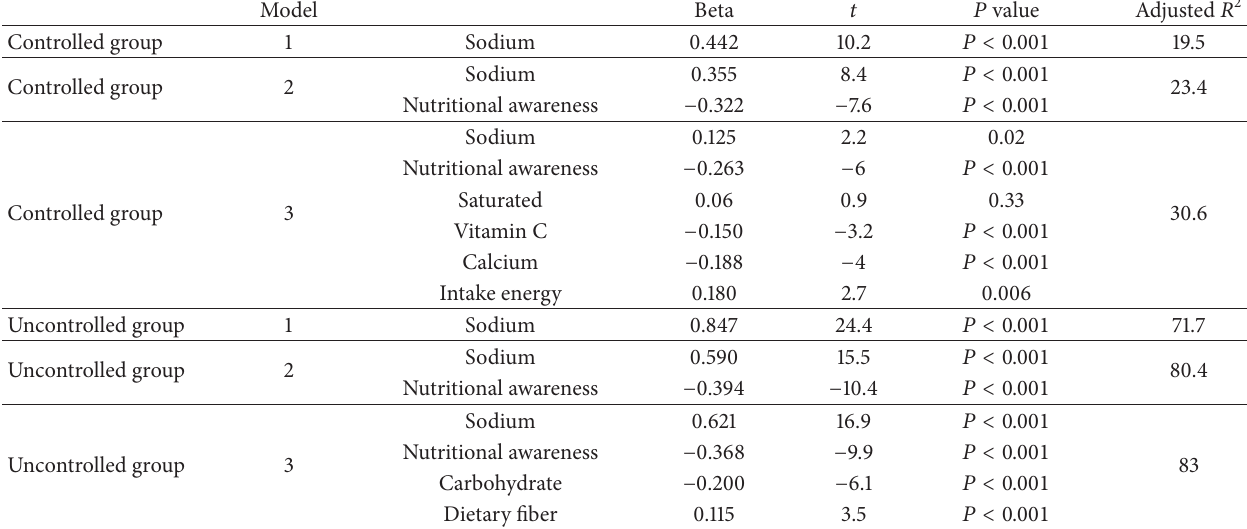
Table 5: Multiple linear regressions of dietary variables in predicting systolic blood pressure in the patients of both